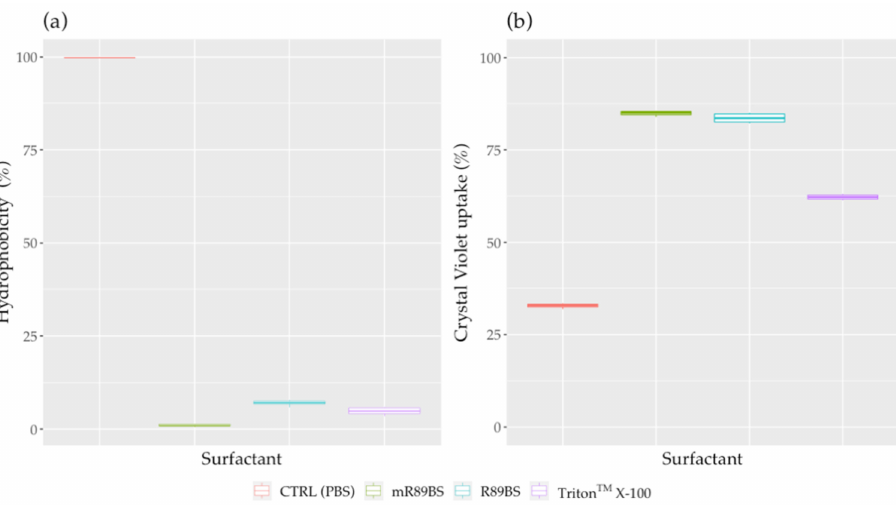
Figure 4. Changes in surface hydrophobicity and crystal violet uptake induced by surfactants. Surface hydrophobicity ( a ) and crystal violet uptake ( b ) of S. aureus ® 6538 TM cells treated with natural (R89BS, mR89BS) and chemical surfactants (Triton TM X-100), compared to control